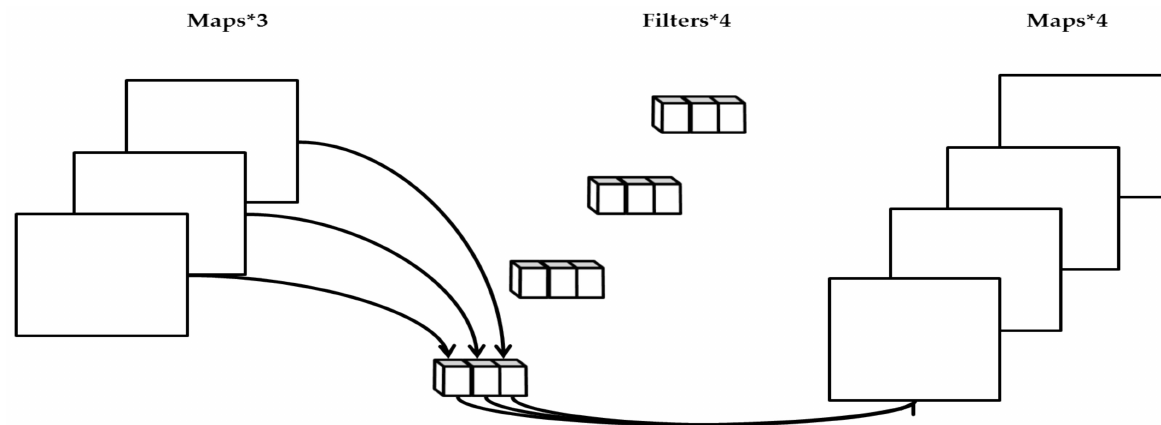
Figure 5. Pointwise